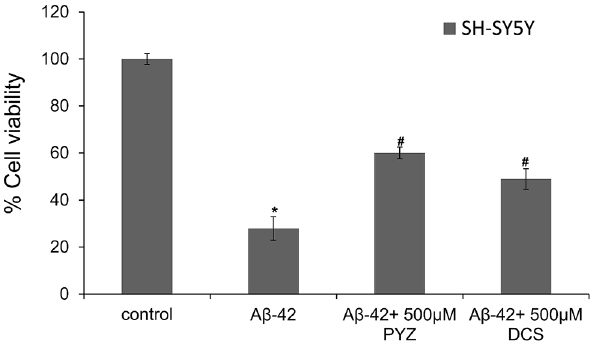
Fig 12. MTT reduction assay for cell cytotoxicity of 70 h aged A β -42 fibrils in absence and presence of different concentration of 500 μ M DCS and PYZ individually in SH-SY5Y cell lines. Control represents cell lines without prior exposure to A β -42 fibrils. * Statistically different from the control group, p (cid:6) 0.01 and # statistically different from the HEWL, p (cid:6)